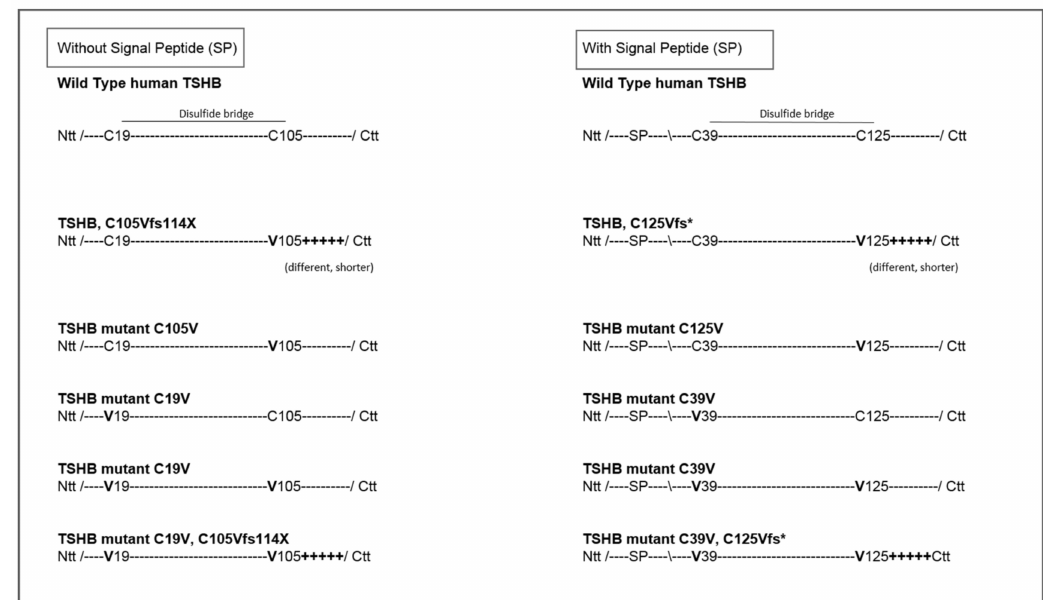
Figure 4. Di ff erent TSHB constructs used in this current study. This figure shows specific features of TSHB WT and tested mutations. Left: In this study we used the numbering system counted without the signal peptide. Right: WT and mutants are shown with SP, which leads to a di ff erent numbering of amino acids (20 amino acids more), while the constructs are finally identical compared to the left